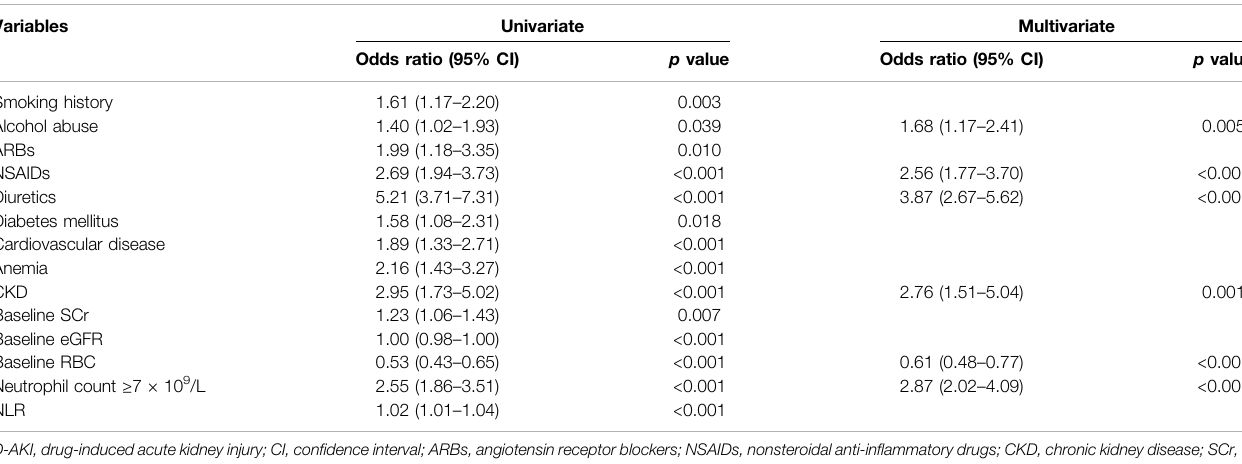
TABLE 3 | Univariate and multivariate analysis of predictors for D-AKI.